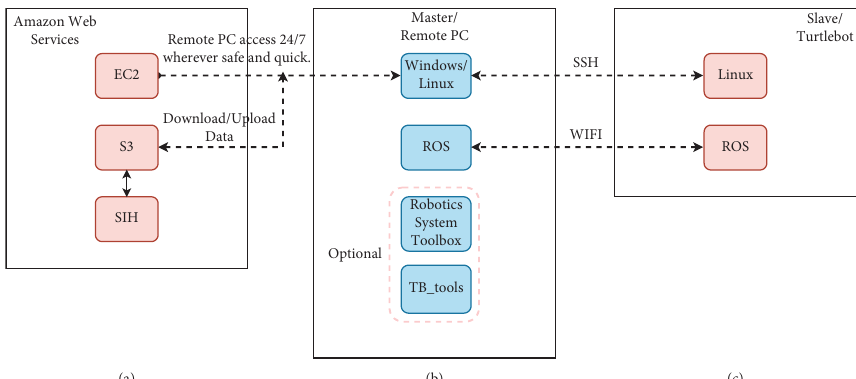
Figure 3: Software architecture. (a) AWS services are used to remotely control (services explained in the next subsection 3.2). (b) A remote PC is used to control TurtleBot3. (c) Te TurtleBot3 used for SLAM and navigation techniques.